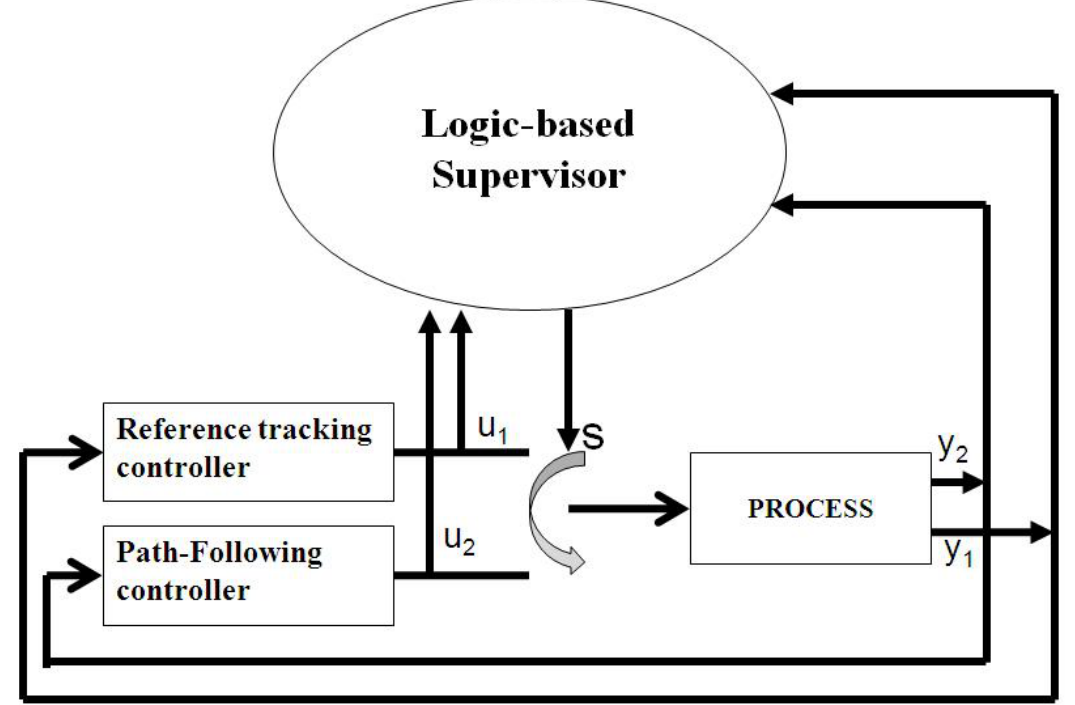
Figure 5. Logic-based Supervisor ( LBS) control in a sun tracking